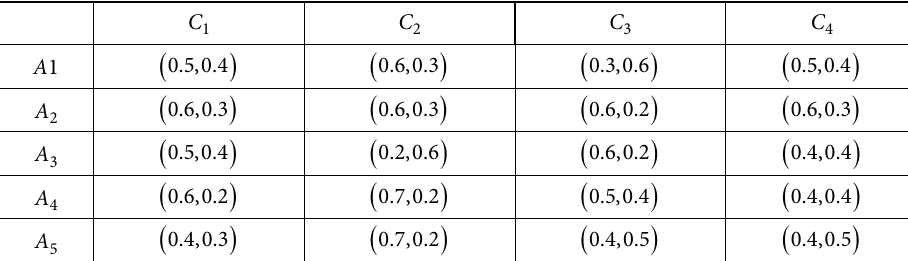
Table 1. Intuitionistic fuzzy decision matrix 1 R  given by 1 D C 1 A